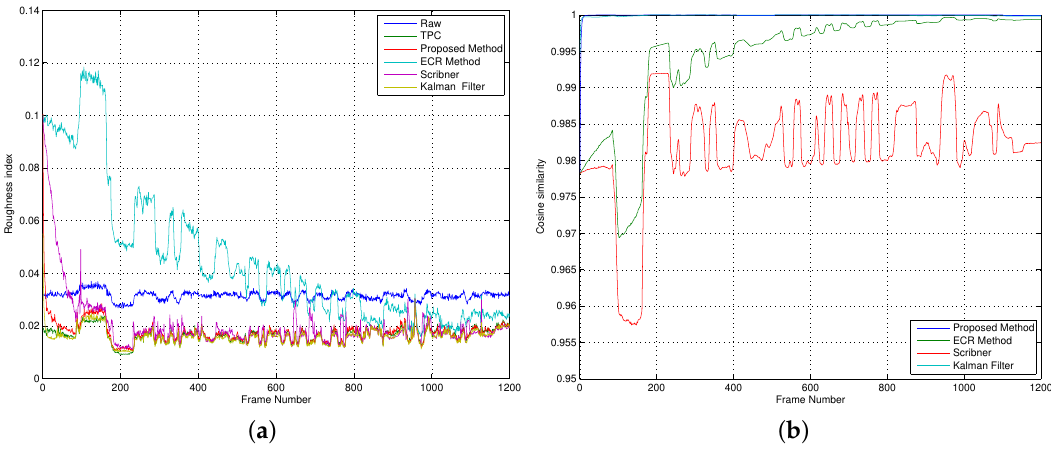
Figure 7. Assessment of the image quality rendered by the different non-uniformity correction (NUC) methods. ( a ) Roughness index; ( b ) Cosine